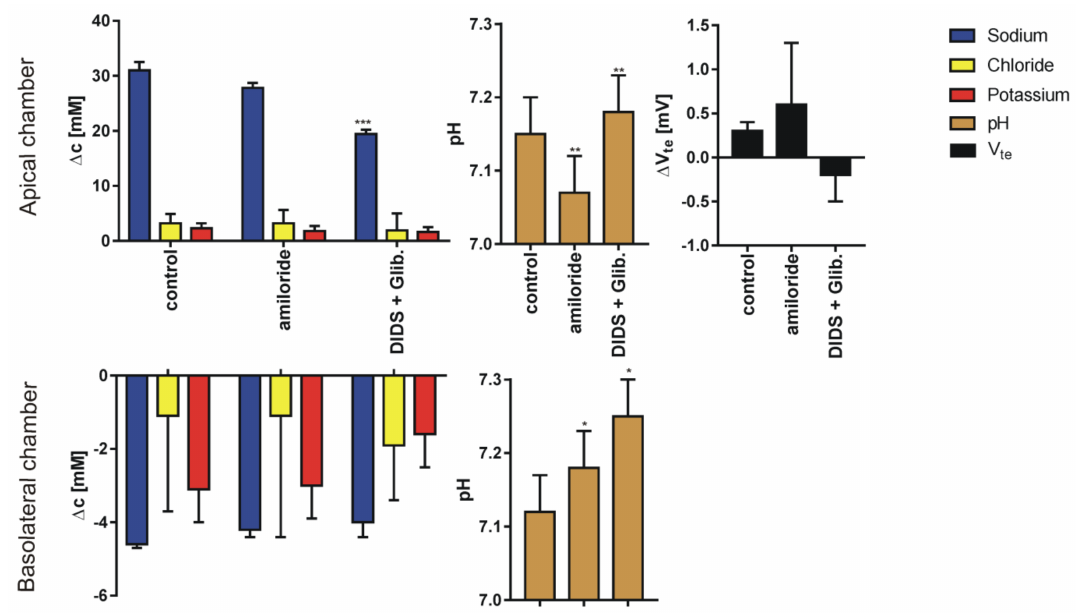
Figure 3. The results (Mean ± SD) of experiments performed in sodium gradient (apical side, KHS2; basolateral side, KHS1) in control conditions and after supplementation of the solution with ion channel blockers. The graph represents: sodium, chloride, potassium transport across the epithelial cell monolayer expressed as the concentration change measured 10 min after appropriate solution flow stop; final pH value and the transepithelial potential di ff erence change (N = 8–10 for Cl − , Na + and V te , N = 6 for K + and pH, dependent sample t-test, * p < 0.05, ** p < 0.01, *** p < 0.001). Note di ff erent scales for apical and basolateral